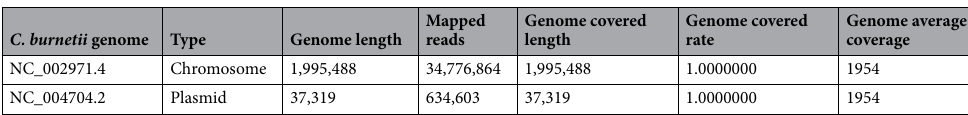
Table 4. Alignment results of C. burnetii